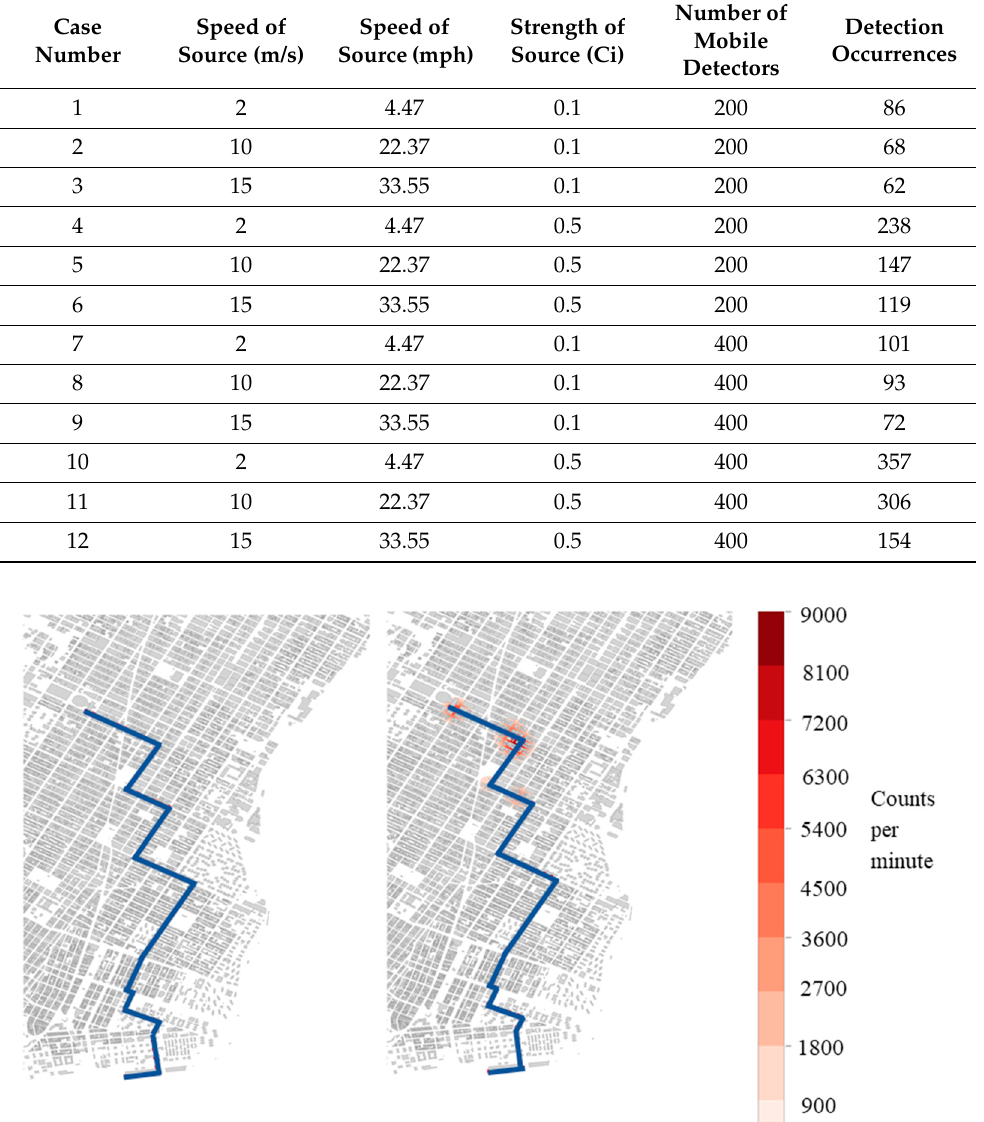
Table 1. 100 cases were simulated with varying source speed and strength for 200 or 400 detectors. Source paths were identical in each case. Mobile sensors followed 200 or 400 identical routes.